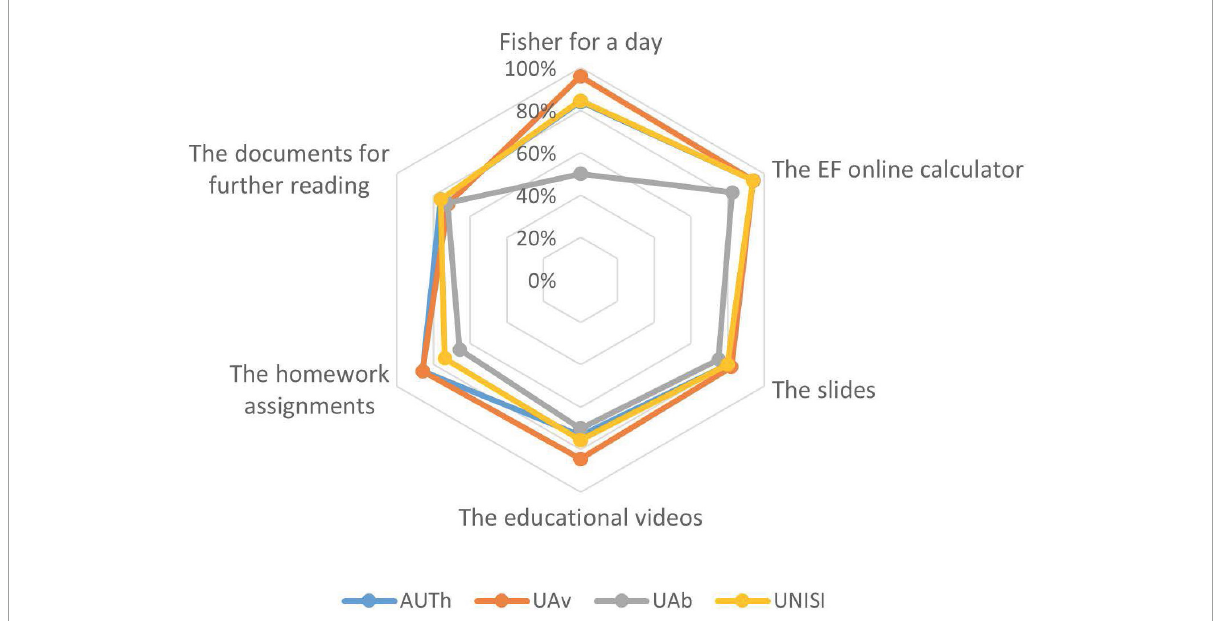
FIGURE6 Satisfaction level of the common education materials in the four participating